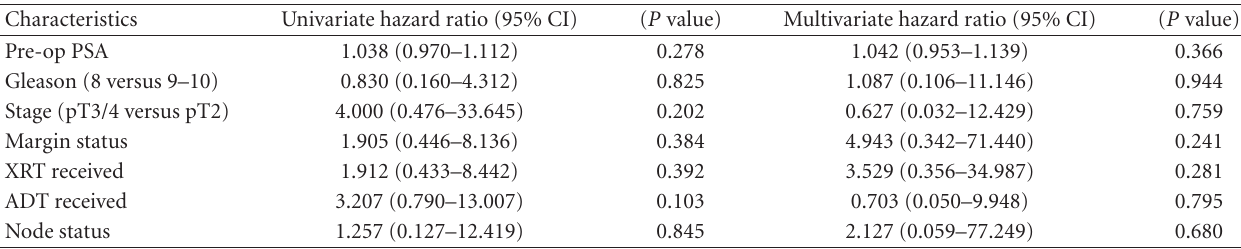
Table 2: Binary logistic regression for prostate cancer-specific mortality.